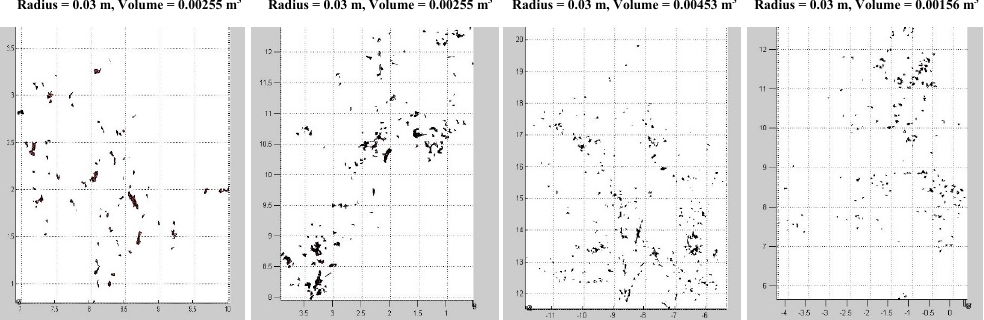
Figure 11. Manually observed low point density of branches affected by longer distances from the scanner and obstruction by leaves.